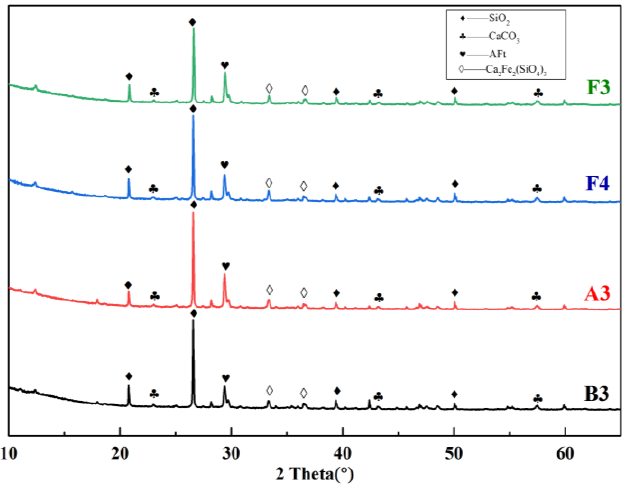
Figure 7. XRD patterns of the different samples.